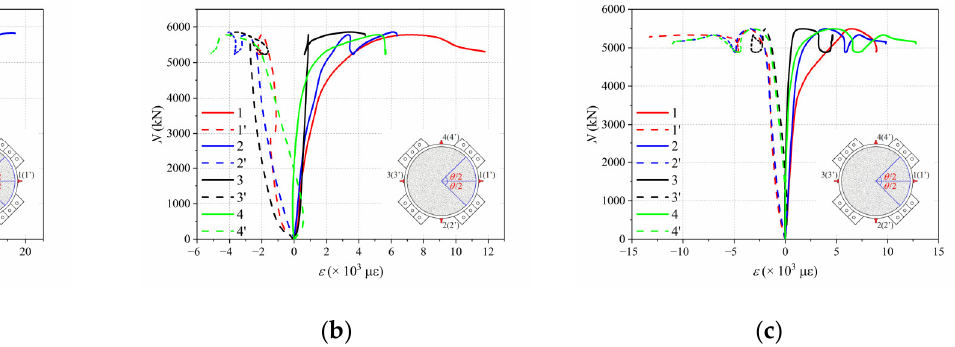
( c ) Figure 12. N -  curves at the cross-section of a 1/2 height of BWCFST specimens with interfacial gap of different  : ( a )  = 90°; ( b )  = 180°; ( c )  = 270°.